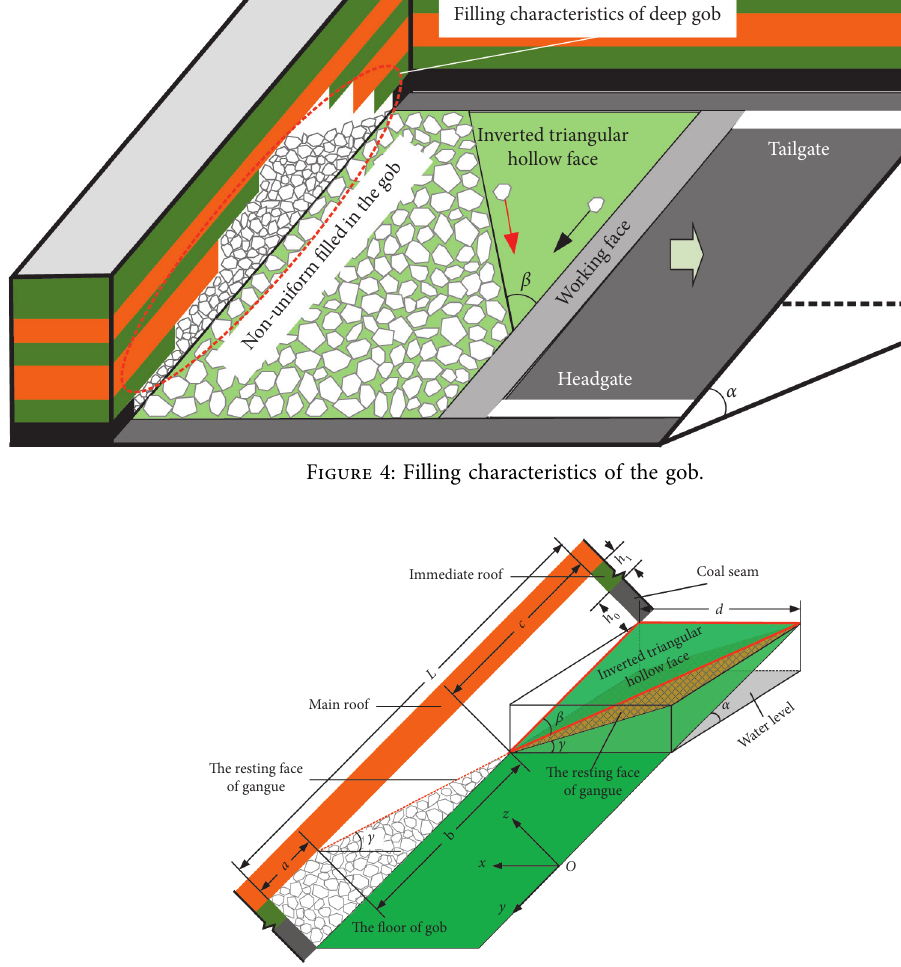
Figure 5: Schematic of gob-filling